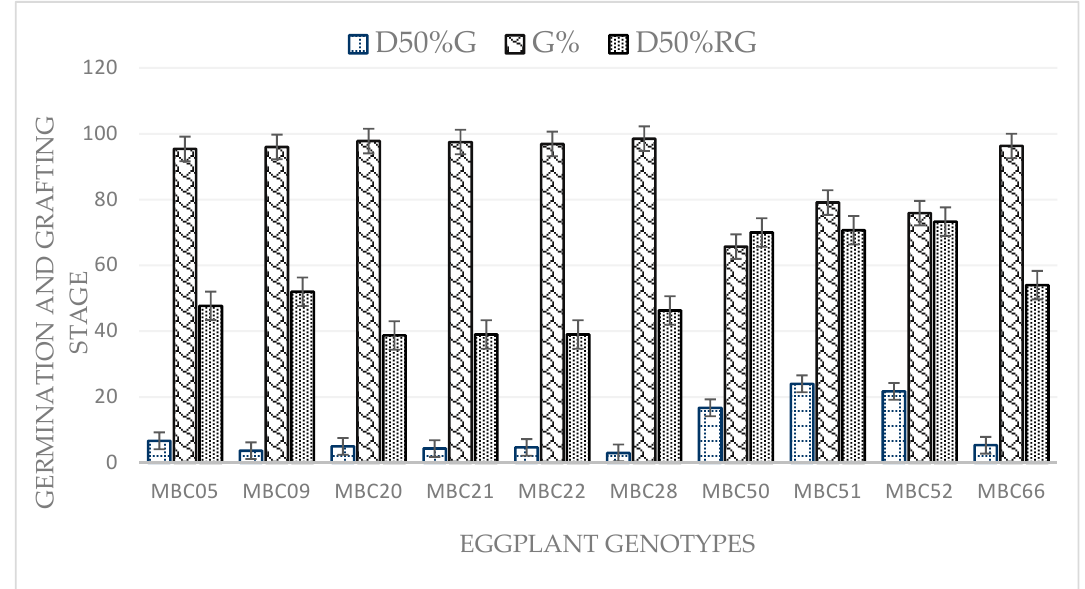
Figure 1. Day to 50% germination (D50%G), germination percentage (G%) and days to 50% reach the grafting (D50%RG) stage, with significance level p = 0.05.